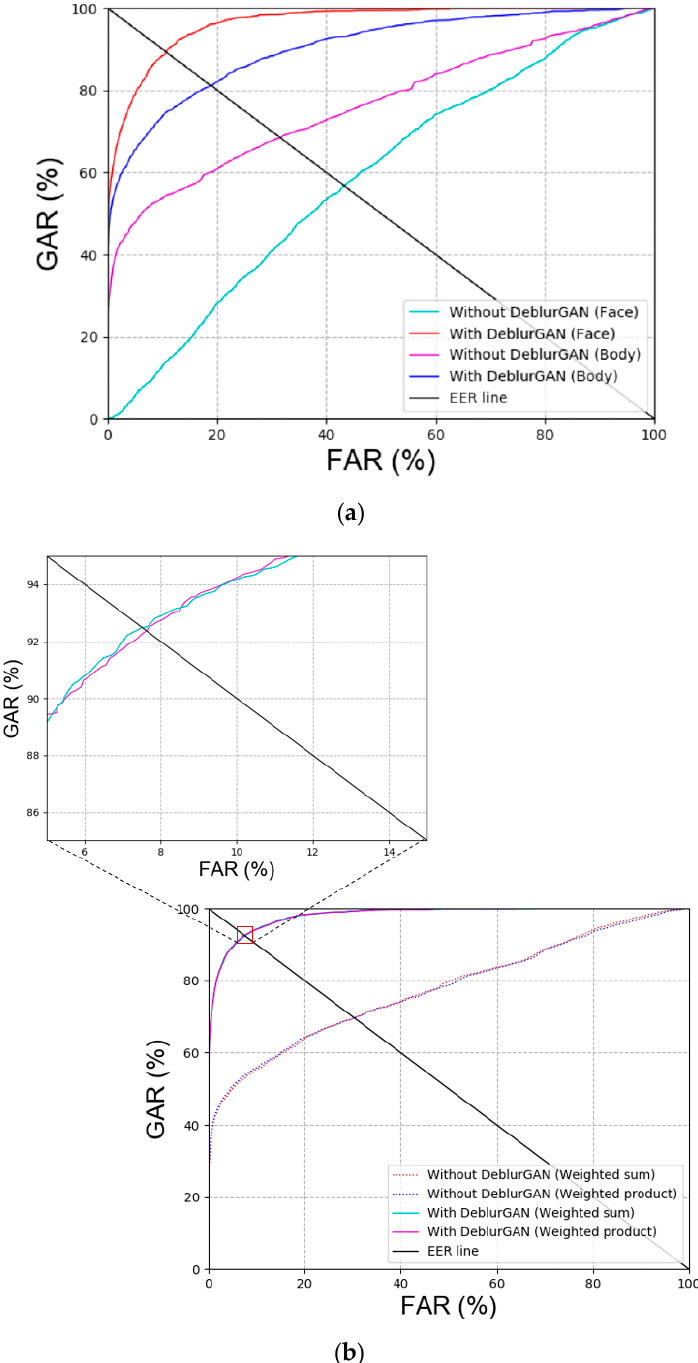
Figure 7. Receiver operating characteristic (ROC) curves with or without DeblurGAN performance of DFB-DB2 ( a ) face and body recognition result and ( b ) score-level fusion result.